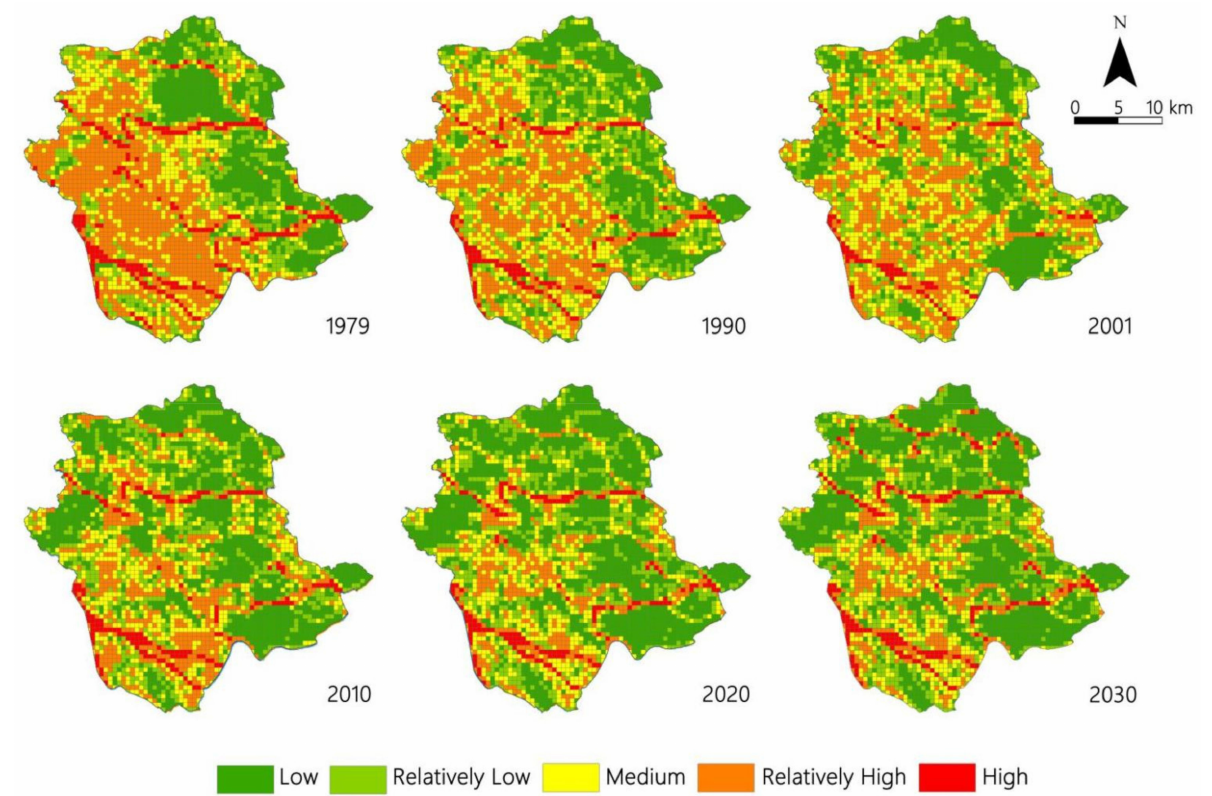
Figure 9. Spatial pattern of ESV in the study area from 1979 to